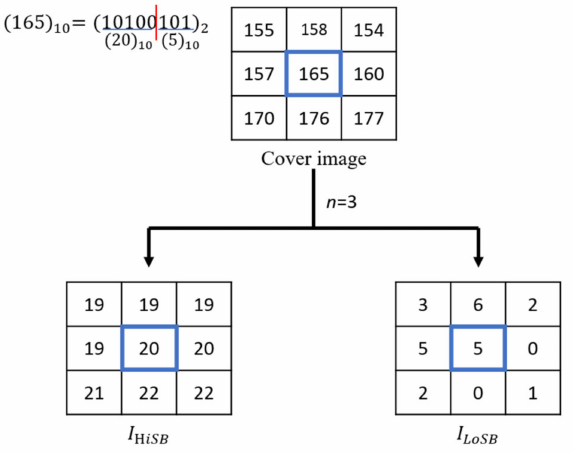
Figure 2. Pixel is divided into two planes, I HiSB image and I LoSB image. The TLE method sorts the up, down, left, and right pixel values of the pixel ( x c ) to obtain the result: ( x , x , x , x ) = (19, 19, 20, 22), as shown in Figure 3. π ( 1 ) π ( 2 ) π ( 3 ) π ( 4 )